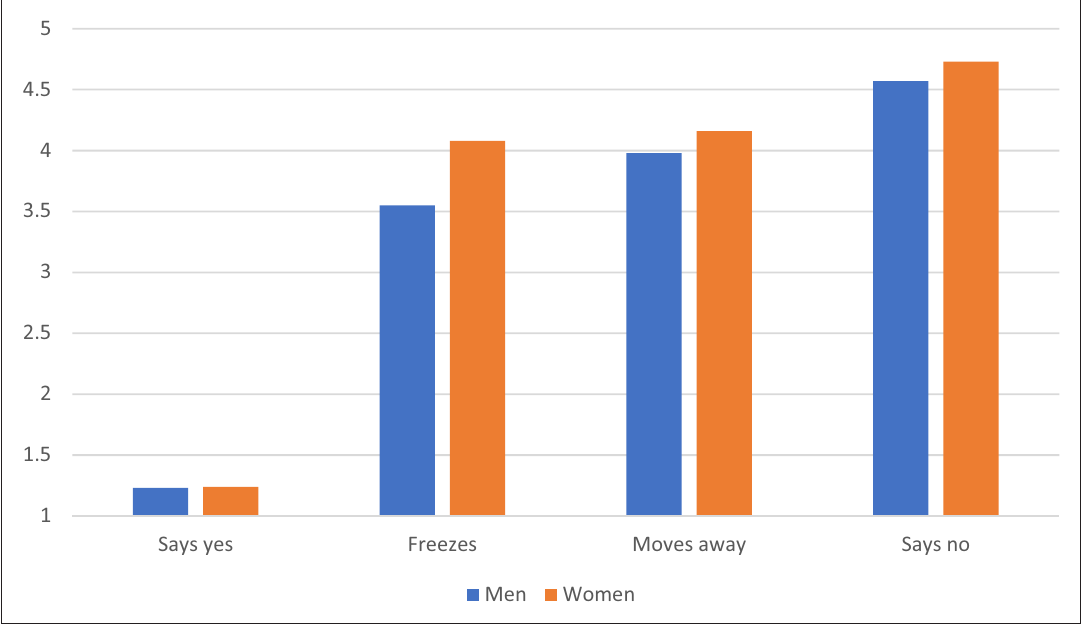
Figure 1 Unacceptability of sex by victim response and participant gender.